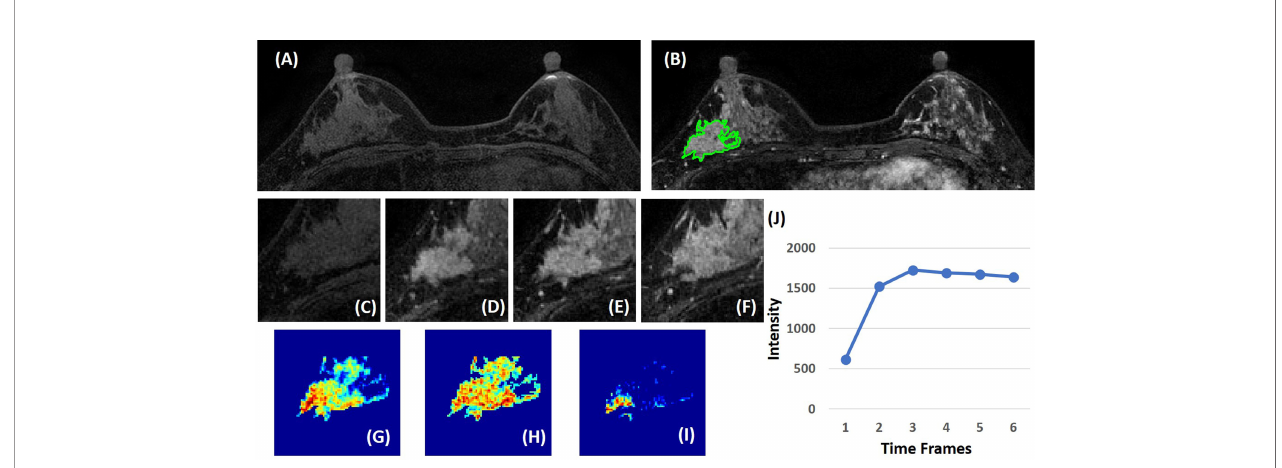
FIGURE 2 | A 41-year-old patient with ductal carcinoma in situ (DCIS). (A) F1 pre-contrast image. (B) F2 post-contrast image. (C – I) : The zoom-in smallest bounding box containing the tumor. (C) F1 pre-contrast, (D) F2 post-contrast, (E) F3 post-contrast, (F) The last F6 post-contrast image, showing a comparable enhancement as in F3. (G) The wash-in signal enhancement map F2 – F1. (H) The maximum F3 – F1 signal enhancement map. (I) The wash-out F6 – F3 map. (J) The DCE time course shows a plateau pattern, after reaching the maximum in F3.